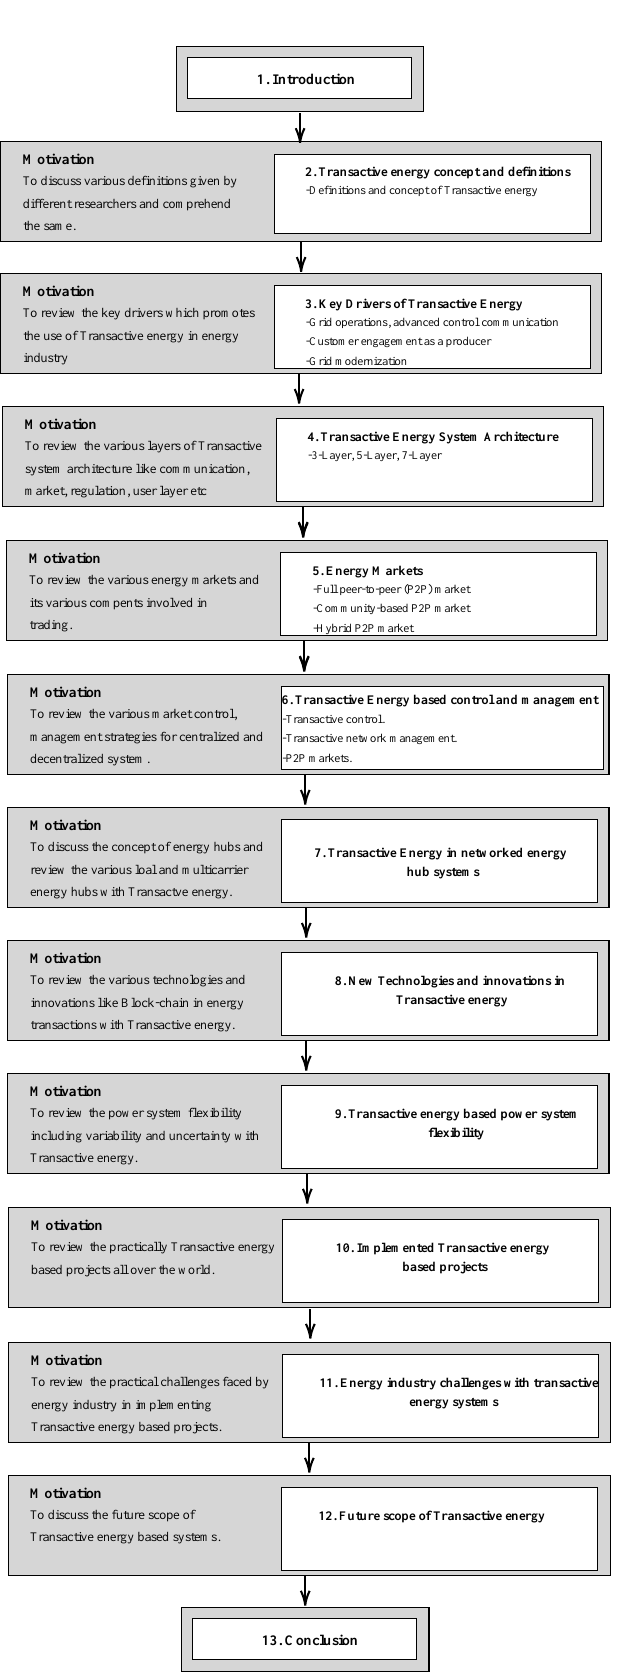
Figure 1. Structure of the